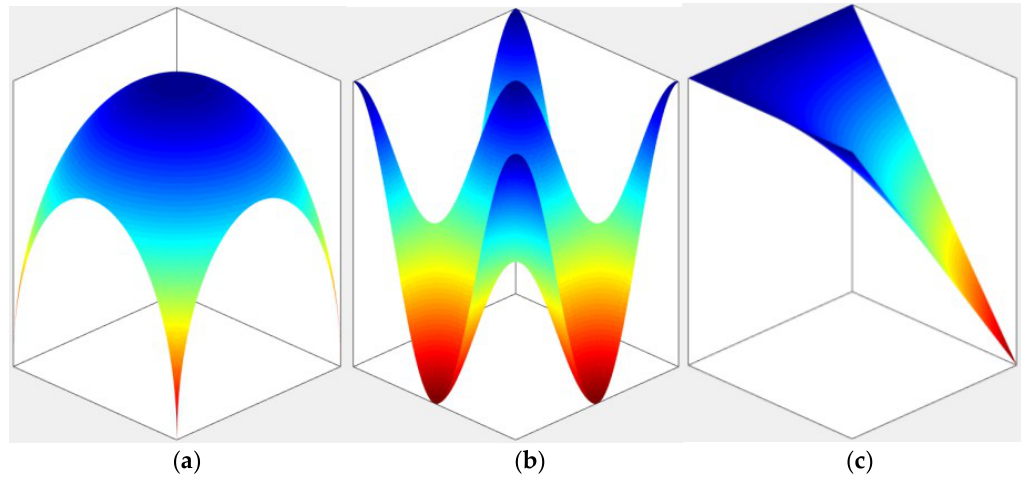
Figure 14. Test virtual objects: ( a ) Spherical surface; ( b ) Complex surface; ( c ) Simple surface.